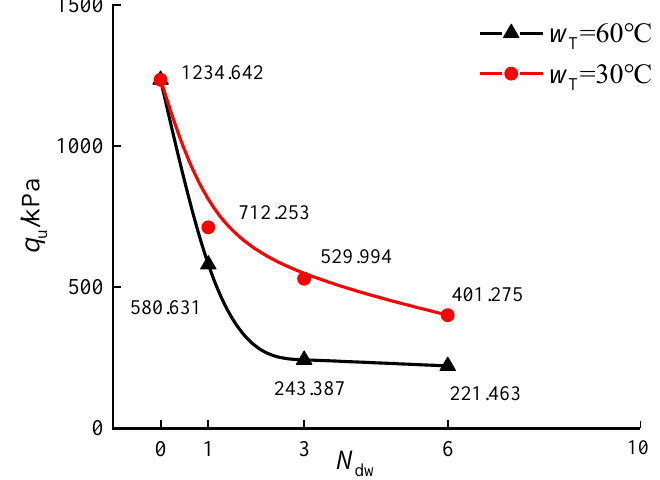
Figure 28. Dry – wet cycle test of the solidified waste silt with curing agent content of 6%. Figure 28. Dry-wet cycle test of the solidified waste silt with curing agent content of